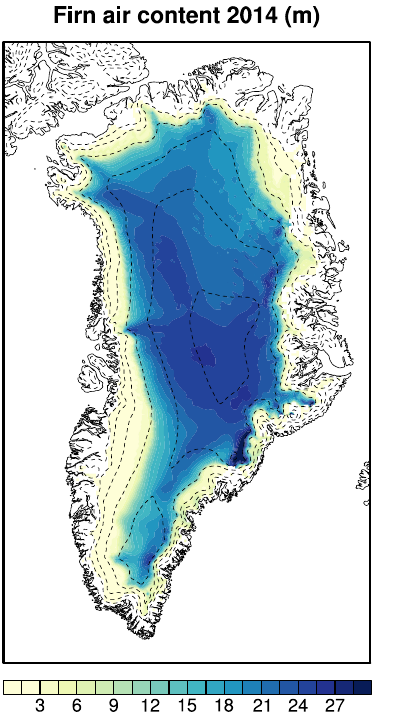
Figure 7. Modelled average firn thickness change ˙ h (in cmyr − 1 ) for three periods: (a) 1980–2014, (b) 1980–1995 and (c) 1995–2014. The equilibrium line (according to the RACMO2.3 SMB) is shown as a thick black line in (a) . Note that the colour scale is asymmetric around 0. In the ablation area, where no firn layer is present, ice thickness change by surface processes is